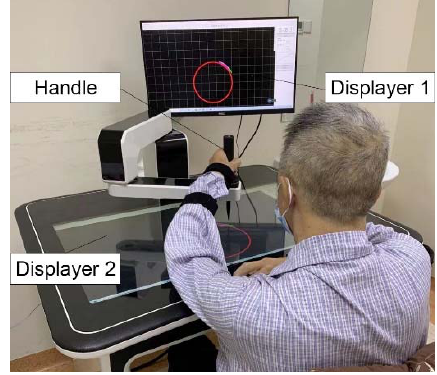
Figure 6. The experimental setup of subjects.